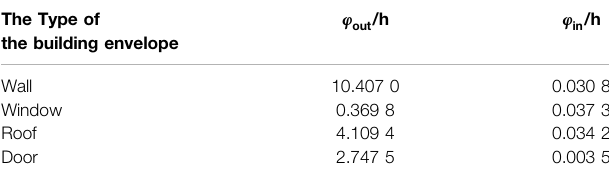
TABLE 1 | Parameters related to VES and PV. TABLE 2 | Heat lags of building